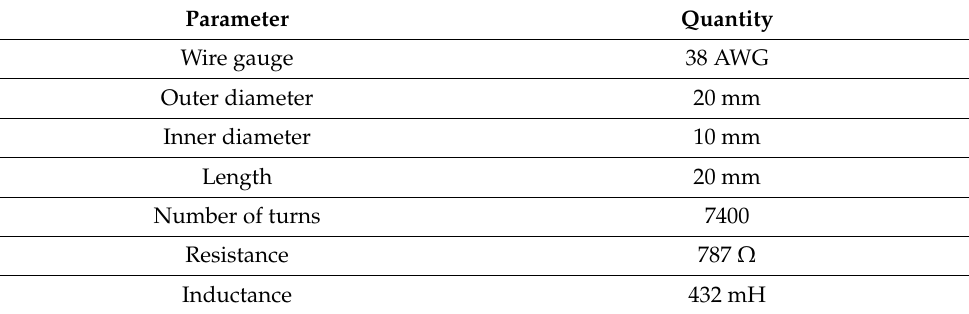
Table 1. Parameters of a single